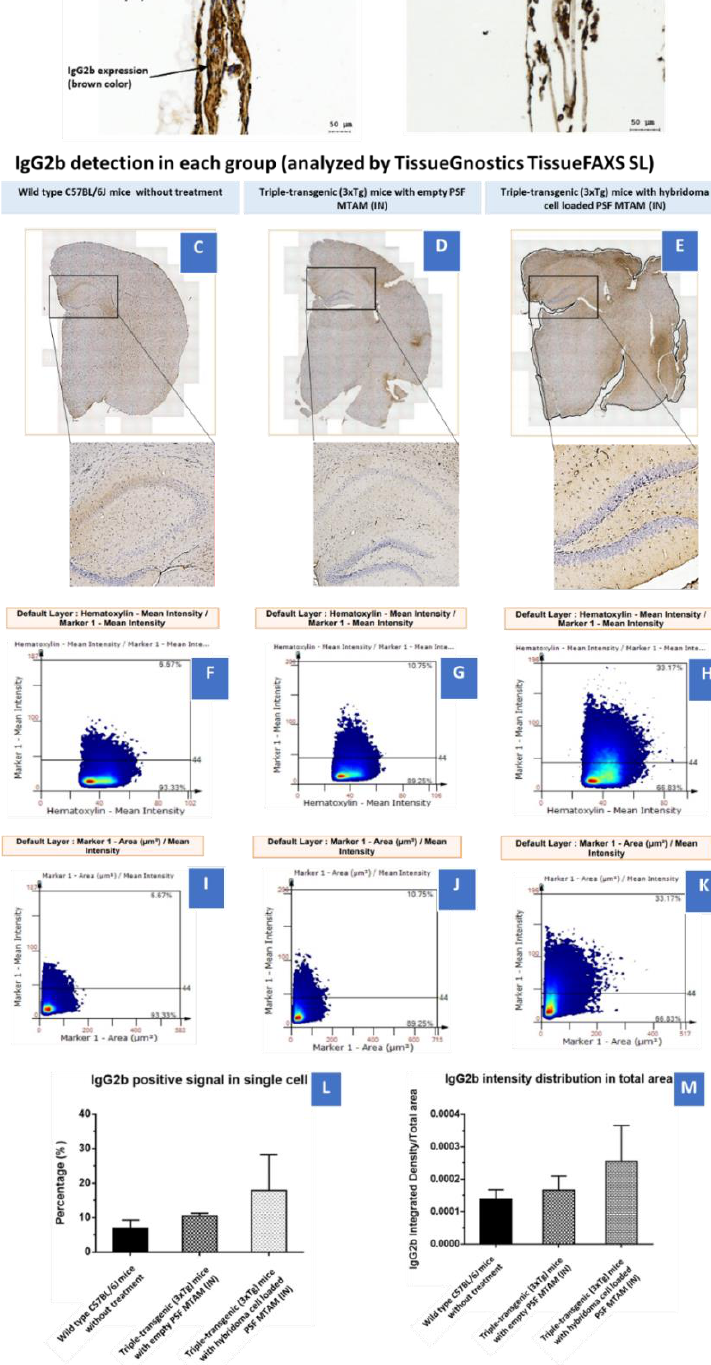
Figure 6. ( A ) Immunohistochemistry of hybridoma cell loaded PSF MTAMs. The nucleus of the hybridoma cells were stained blue from the hematoxylin dye, while the IgG2b antibodies were stained brown. ( B ) Contrary to ( A ), the lack of blue/brown staining were observed within the empty PSF MTAMs. ( C – E ) Tissue section of the brain of mouse models of; ( C ) Wild-type C57BL/6J mice without treatment ( n = 5), ( D ) Triple-transgenic (3xTg) mice with empty PSF MTAM (IN; n = 3), and ( E ) Triple-transgenic (3xTg) mice with hybridoma cell loaded PSF MTAM (IN; n = 4), along with the